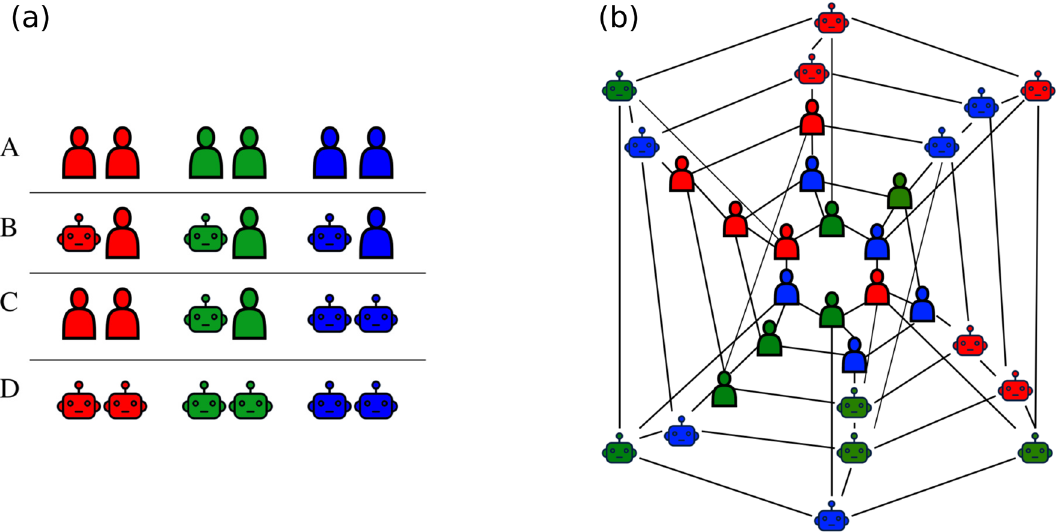
Figure 1. ( a ) Composition of the groups in experimental setups. Each icon represents 5 players or autonomous agents or bots. Setup A consisted of only human players, the hybrid setups B and C had 15 human and 15 agent players with varying group consistencies, and setup D consisted of only agent players. The difference in group consistencies between setups B and C provided different numbers of human–human, human–bot and bot–bot interactions. ( b ) An example snapshot from a game with setup B. The initial configuration of a game with setup B. The largest clusters are red 7, green 4 and blue 2. Each network configuration was randomized with